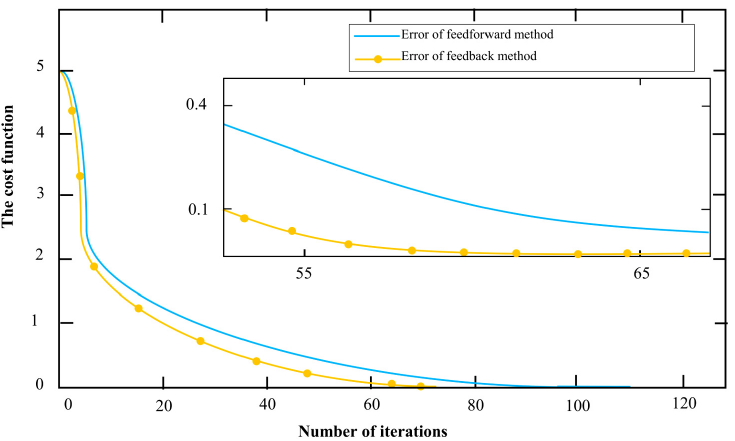
Fig. 3. The errors between the approximate solution and the exact solution with feedback and feed- forward neural networks.